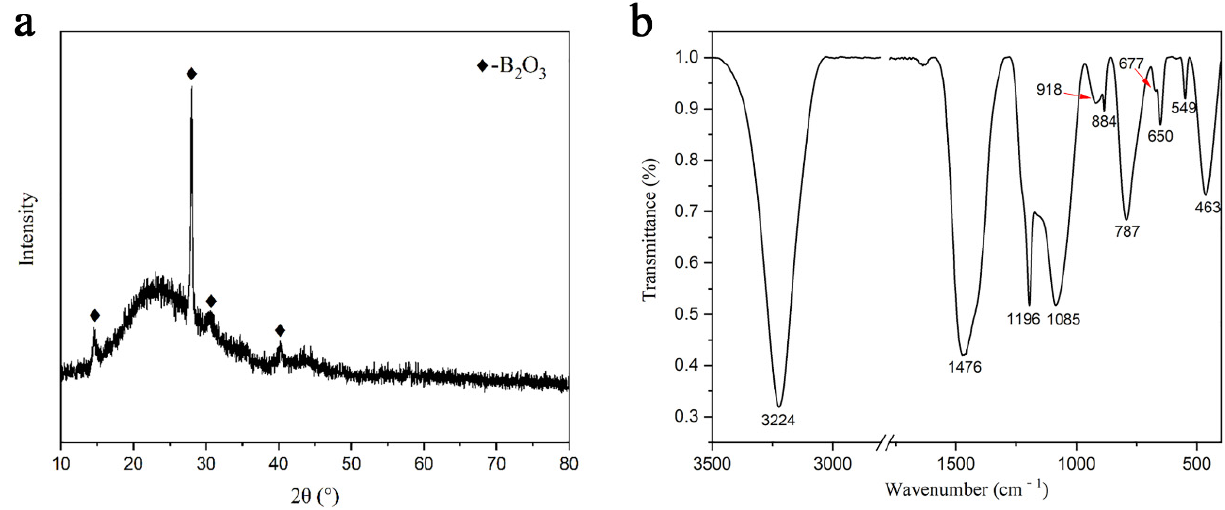
Figure 6. X-ray diffraction (XRD) pattern ( a ) and the Fourier transform infrared (FTIR) spectrum ( b ) of the SiBCN phenolic resins after oxidized in the muffle furnace at 1000 °C.